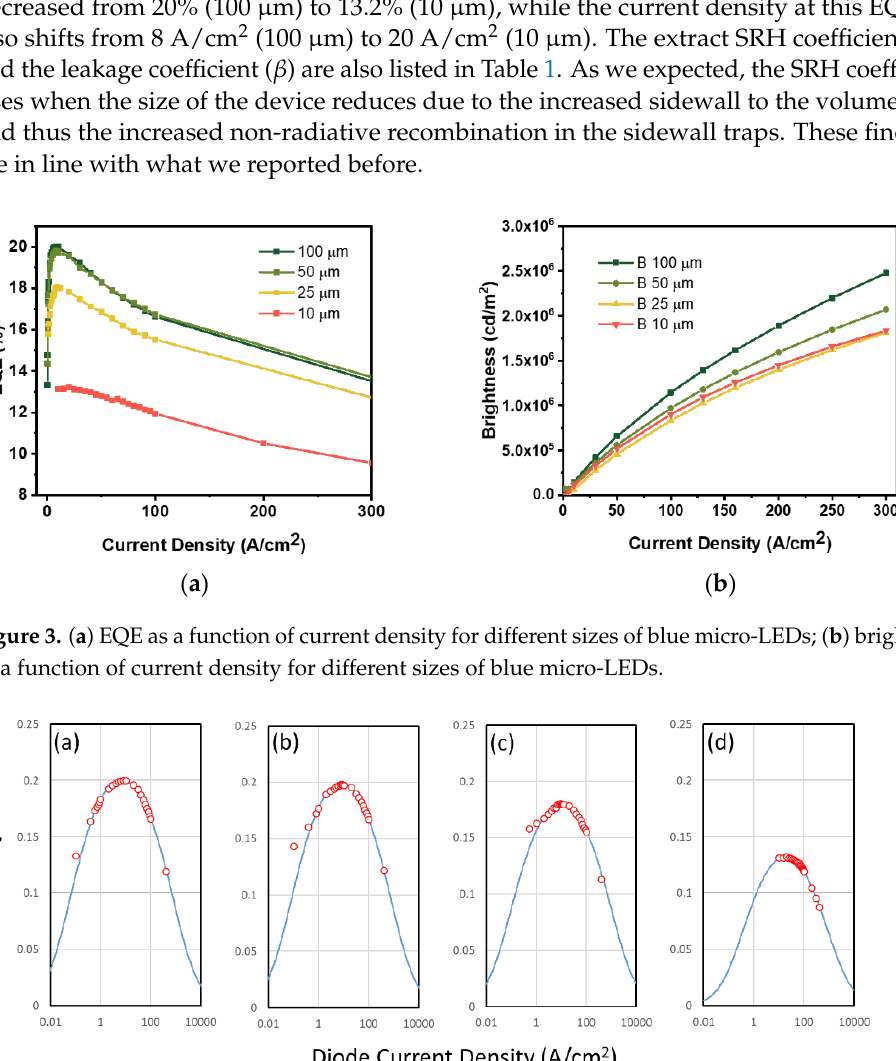
Figure 3. ( a ) EQE as a function of current density for different sizes of blue micro-LEDs; ( b ) bright- ness as a function of current density for different sizes of blue micro-LEDs.